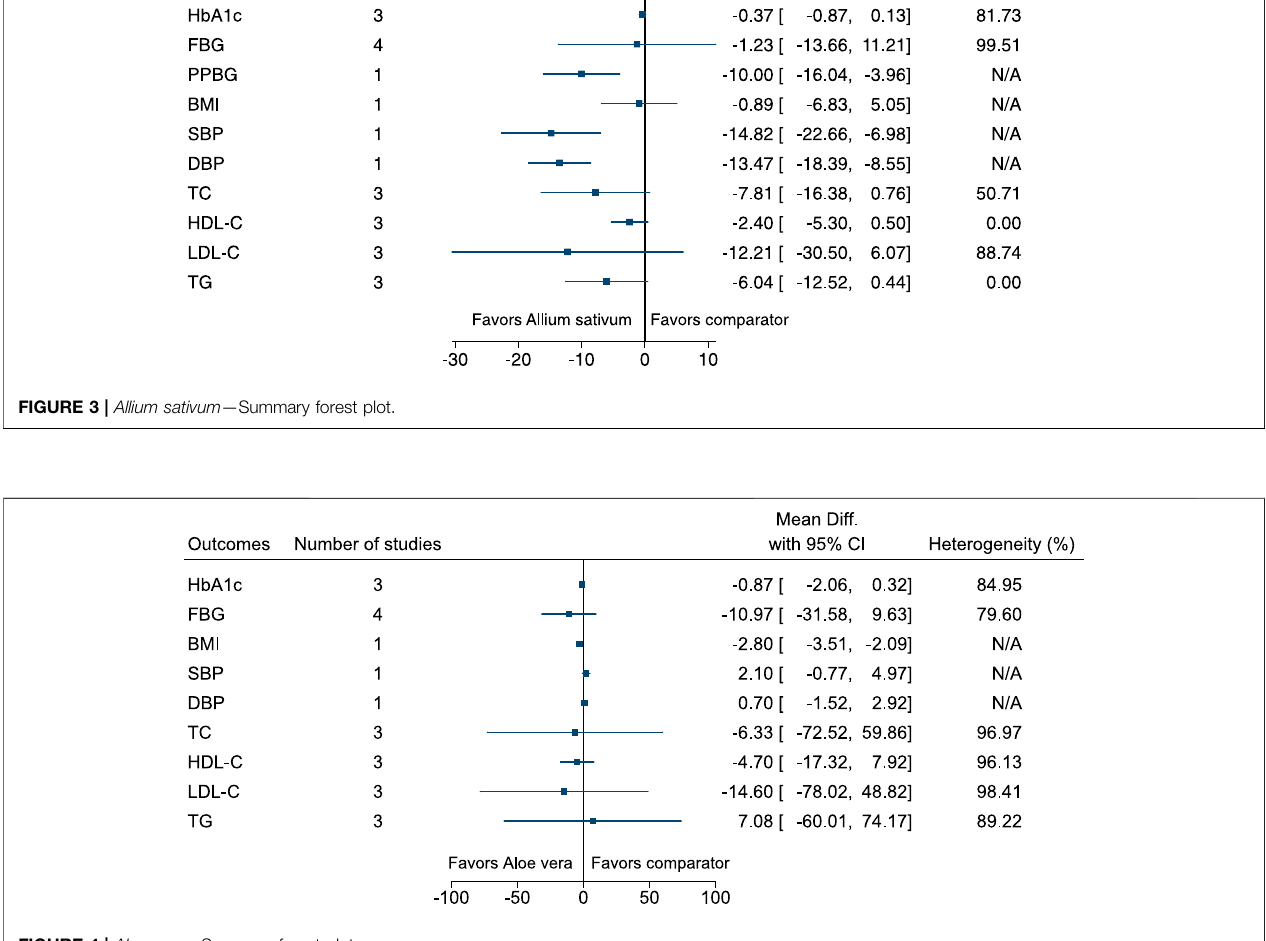
FIGURE 4 | Aloe vera — Summary forest